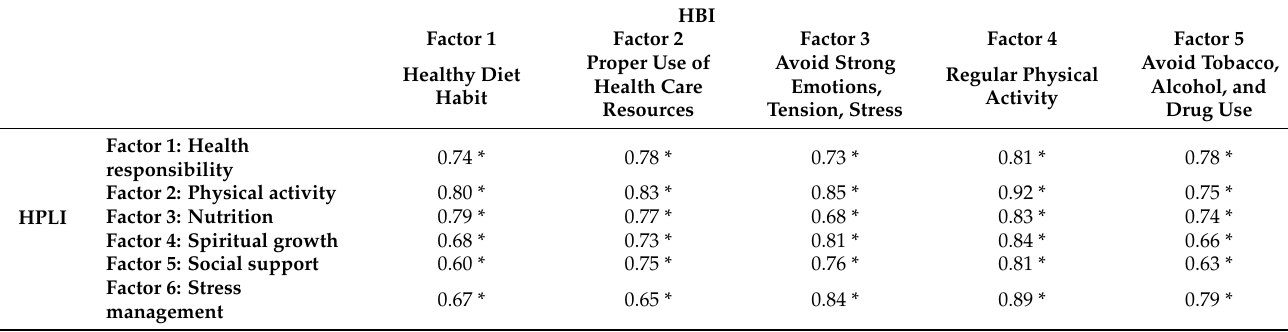
Table 7. Correlation analysis of post-test results of various factors between the HBI and HPLI in